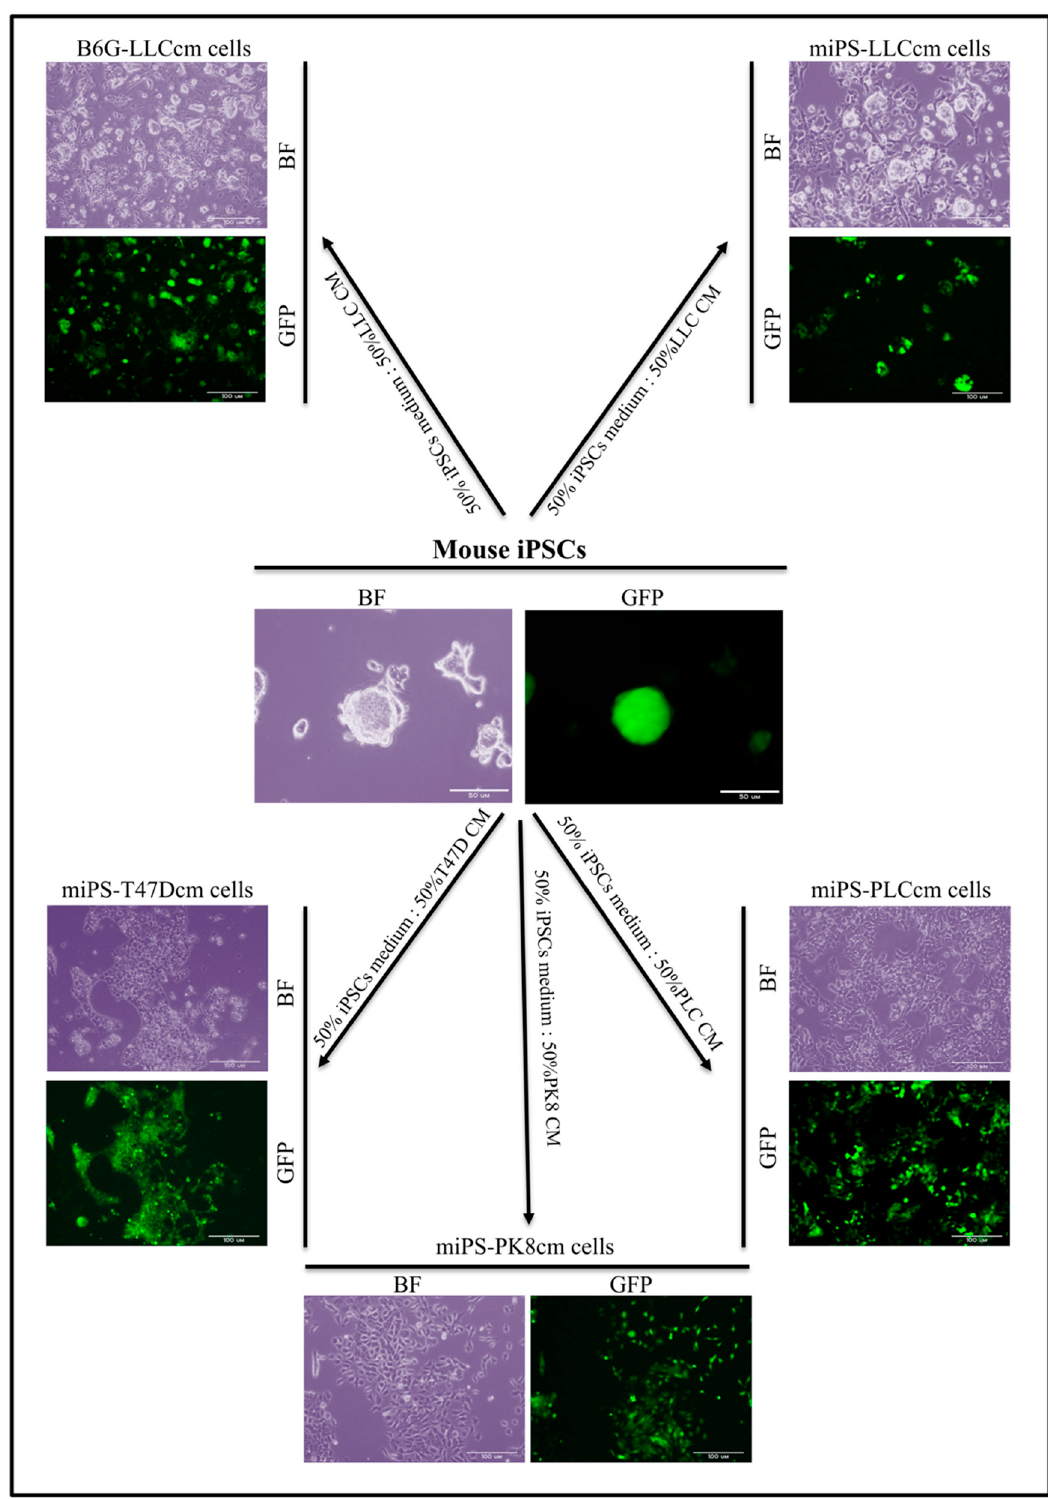
Figure 3. Summarized scheme for mouse induced pluripotent stem cells (iPSC)/embryonic stem cell (ESC) conversion in the presence of conditioned medium (CM). CM from different cancer cell lines (Lewis lung carcinoma LL/2 (LLC1), breast cancer cell line (T47D), liver cancer cell line (PLC/PRF/5), pancreatic carcinoma cell line (PK-8)) induce the conversion of iPSCs/ESCs into cancer stem cells after 4 weeks of treatment. Stemness tracking during conversion by the presence of GFP protein. Scale bar: 100 μ m.